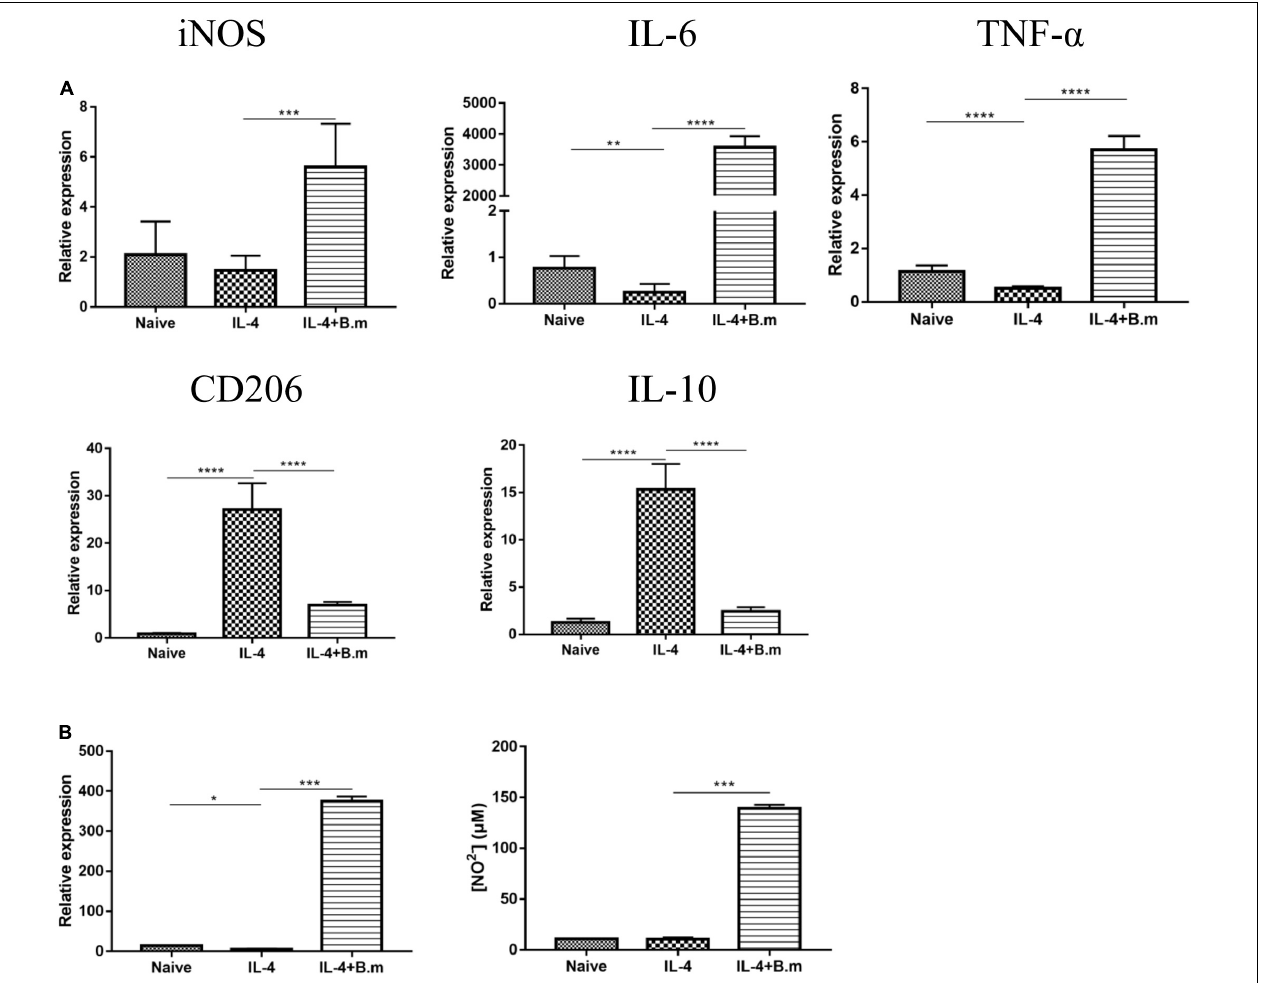
FIGURE 8 | Effects of B. microti culture supernatant on the polarization of M2 macrophage to the M1 phenotype. (A) qPCR analysis of the effects of B. microti culture supernatant on the expression of iNOS, IL-6, TNF- α , CD206, and IL-10 in RAW264.7 cells treated with IL-4; RAW264.7 cells were cultured with mouse recombinant IL-4 for 24 h and then incubated with the B. microti culture supernatant for 24 h. (B) Concentrations of TNF- α and NO 2 − in the cell culture supernatant as detected by using the ELISA kit and Griess reagent, respectively. Error bars are SD; * p ≤ 0.0332, ** p ≤ 0.0021, *** p ≤ 0.0002, **** p ≤